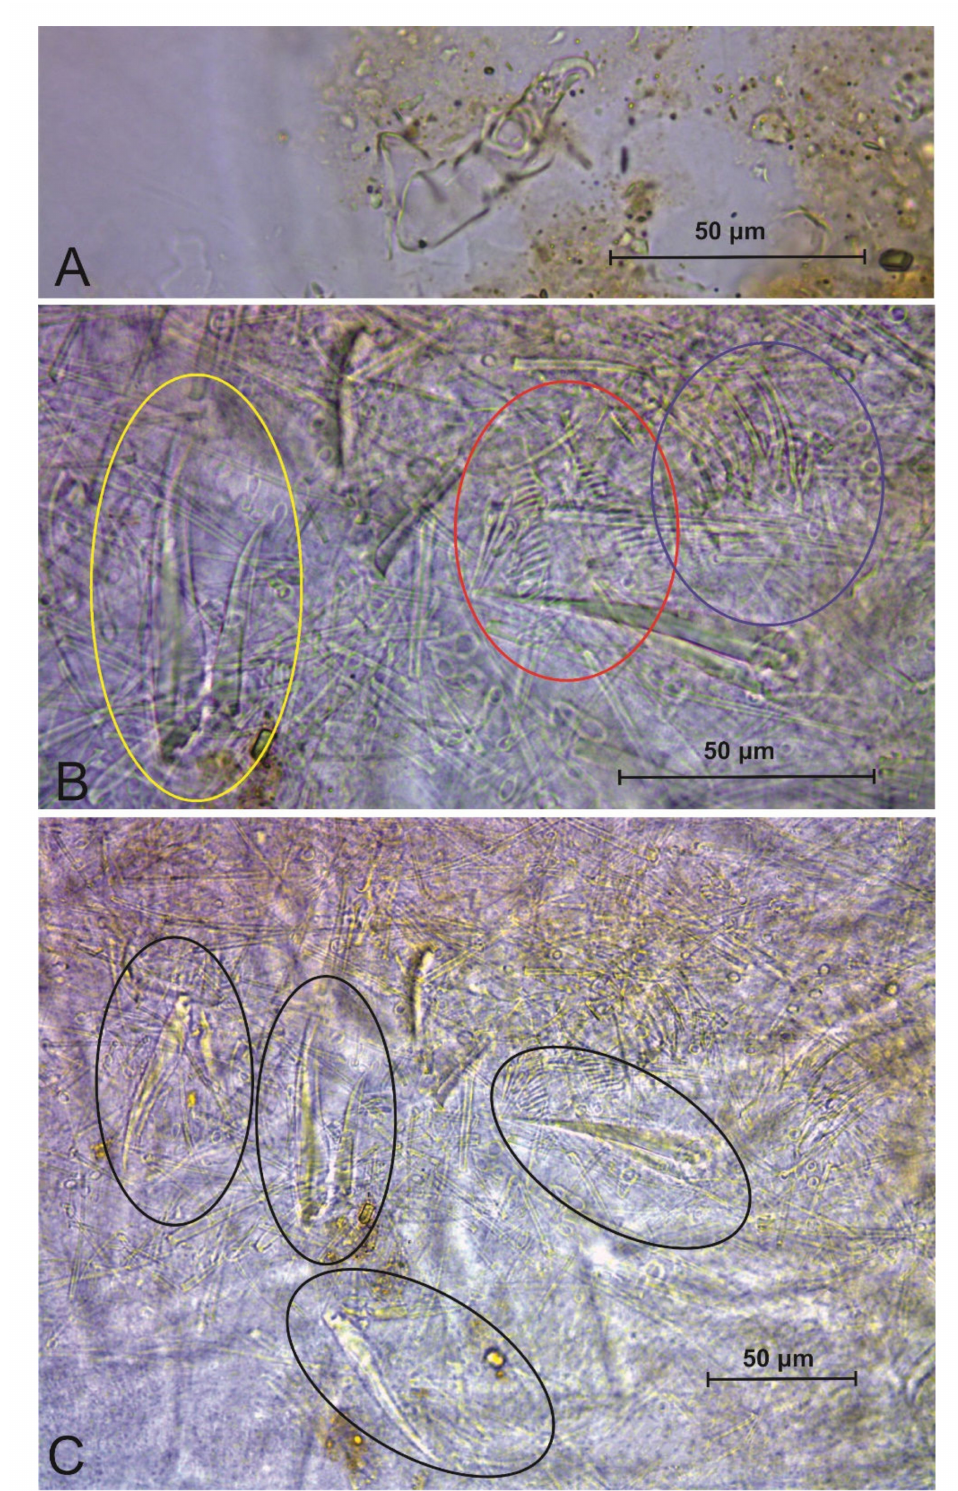
Figure 10. Troglobentosminthurus luridus gen. nov. sp. nov., gut contents: ( A ) a male’s contents, with a mite leg at the center and dark matter mixed with soil particles at the right side; ( B ) holotype (female) contents, yellow circle marks an empodial complex, red marks the testicles, and blue marks one labial palp; ( C ) holotype (female) contents, black circles mark four devoured empodial